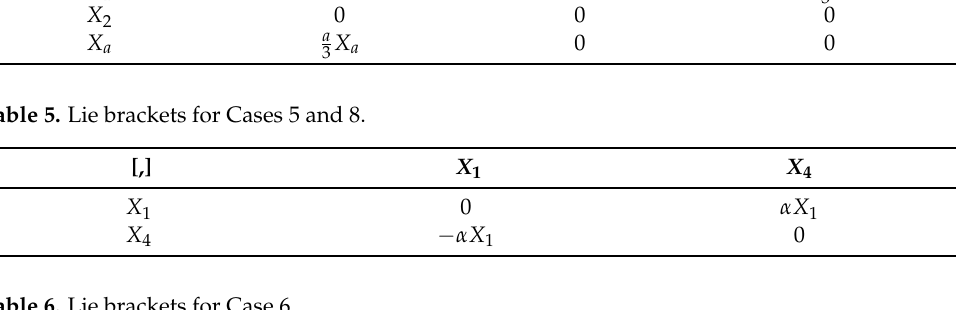
Table 6. Lie brackets for Case 6.